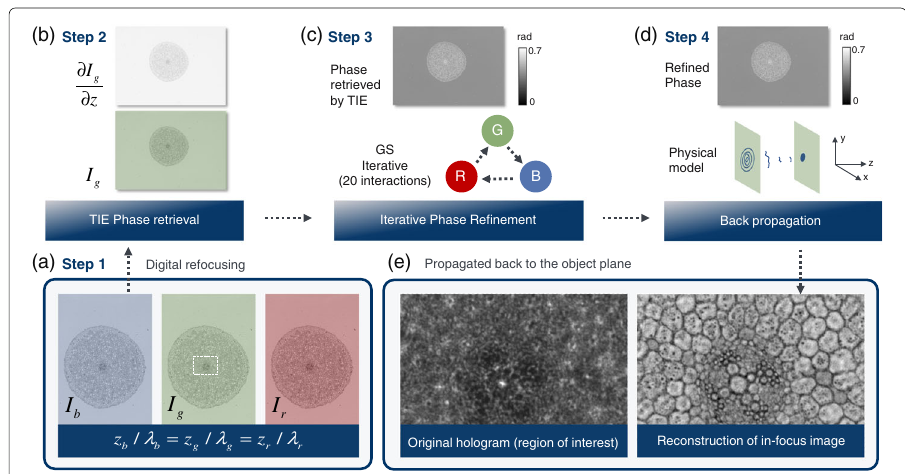
Fig. 27 Technical roadmap of HTL-SCLM with multi-wavelength illumination